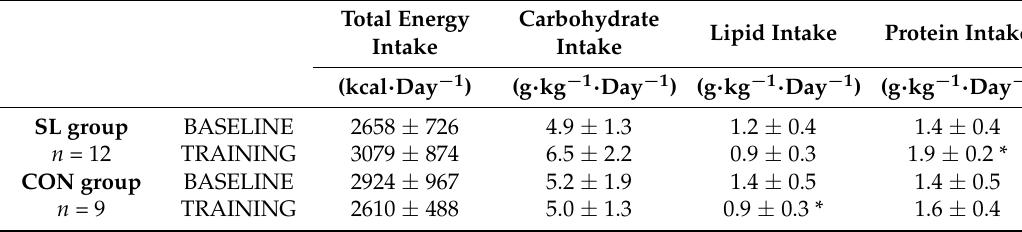
Table 1. Total energy and macronutrient intake for sleep-low (SL) and control (CON) groups before starting the training program (BASELINE) and during the training/diet intervention (TRAINING) (mean ± SD). Total Energy Intake